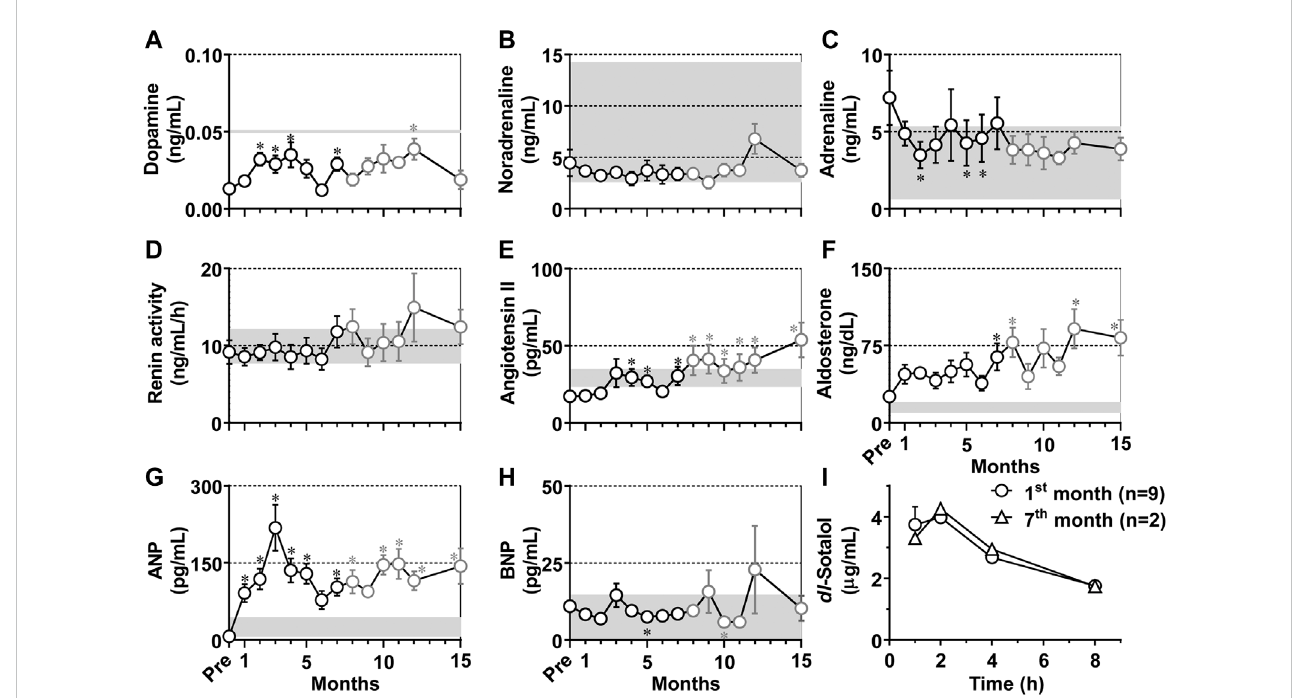
FIGURE 5 (A – H) Timecoursesinchangesintheneurohumoralfactorsintheplasmaoftheatrioventricularblockmonkeys.* p < .05vs.beforeatrioventricularblock (Pre)byFriedmantestwithDunn ’ smultiplecomparisontest.Dataarepresentedasmean±s.e.m.( n =10forPreand1 – 7 months,blacksymbols;and n =8for 8 – 15 months, gray symbols). Gray zones in all panels indicate physiological concentrations calculated by using data in previous reports (Mangan and Mason, 1958; Udelsman et al., 1987; Lenz T et al., 1991; Pai C et al., 2021). ANP, atrial natriuretic peptide; and BNP, brain natriuretic peptide. (I) Time courses of changeintheplasmaconcentrationsof dl -sotalolfollowingoraladministrationof10 mg/kgof dl -sotalolhydrochlorideat1 monthafteratrioventricularblock (mean ± s.e.m., n = 9, circles), and at 7 months after atrioventricular block (mean, n = 2, triangles) in #2 and #8 animals which had developed torsade de pointes 4 and 3 times by dl -sotalol challenge, respectively (see Table